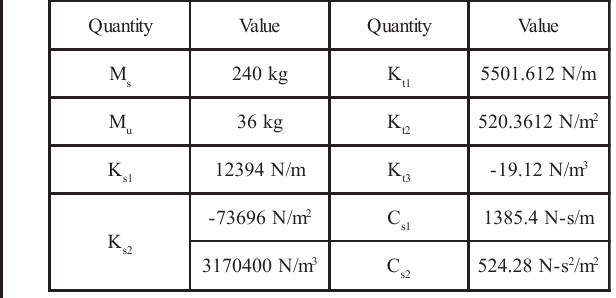
TABLE 1. SUSPENSION COEFFICIENTS VALUES